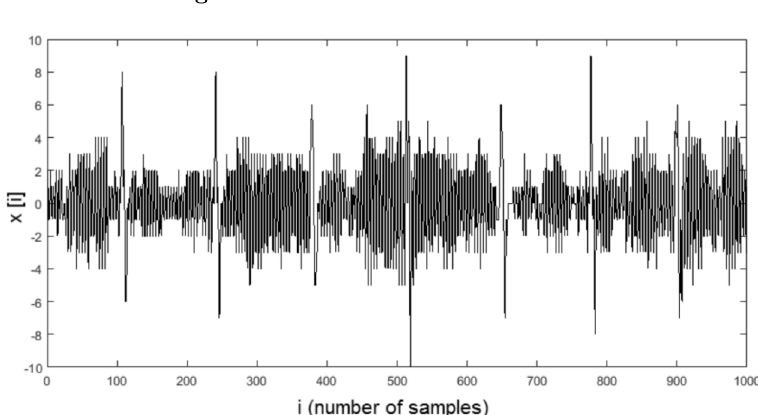
Figure 2. Differentiated EHG signal